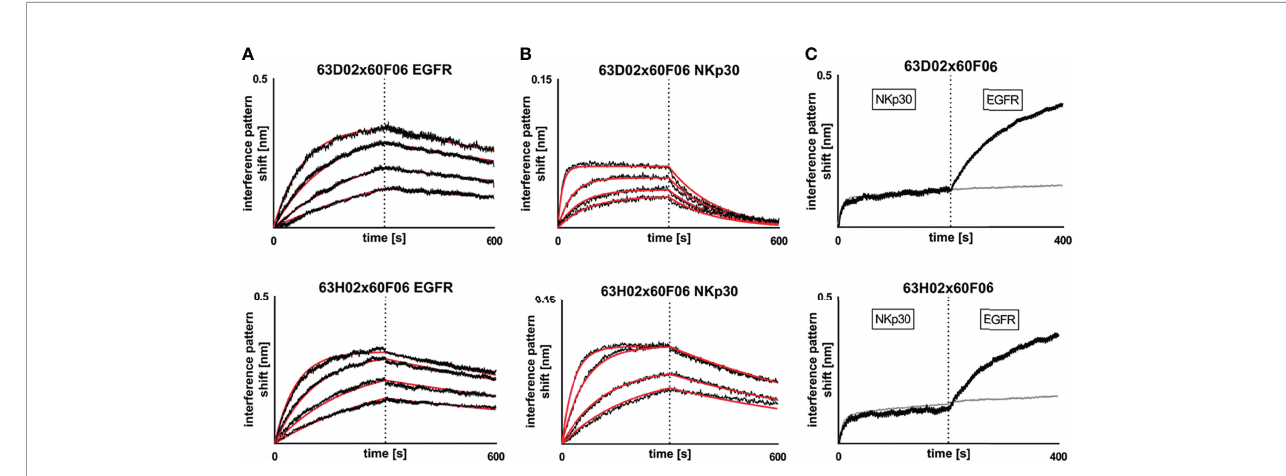
FIGURE 3 | Biochemical characterization of chimeric ultralong CDR-H3 common light chain bispeci fi c antibodies via Biolayer interferometry. Kinetic measurements against recombinant human EGFR extracellular protein (A) or recombinant human NKp30 ECD (B) . Bispeci fi c entities 63D02x60F06 (top) or 63H02x60F06 (bottom) were loaded onto sensor tips. After sensor rinsing, antigen binding was conducted at different concentrations (100 nM, 50 nM, 25 nM and 12.5 nM for EGFR and 50 nM (25 nM for 63H02), 12.5 nM, 6.25 nM and 3.125 nM for NKp30) for 300 s, followed by a dissociation step in kinetics buffer for 300 s. (C) Simultaneous binding of 63D02x60F06 (top) or 63H02x60F06 (bottom) bispeci fi cs against NKp30 ECD and EGFR ECD. Bispeci fi cs were loaded to the sensor tips. After sensor rinsing two consecutive association steps were performed at 100 nM (Nkp30) and 100 nM (EGFR) for 200 s each.